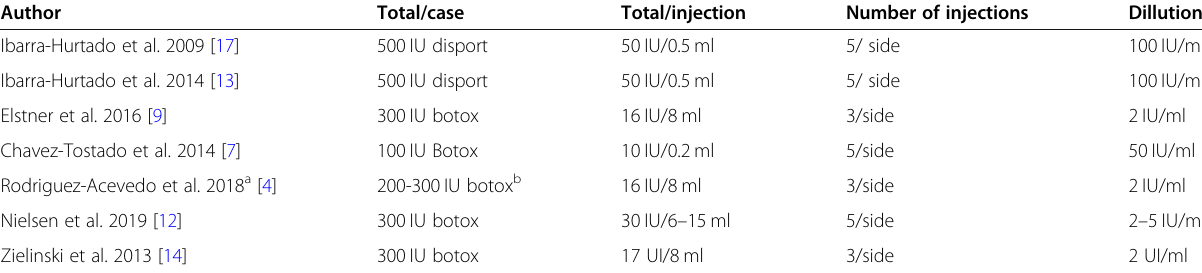
Table 2 BTI to treat CIH: doses and